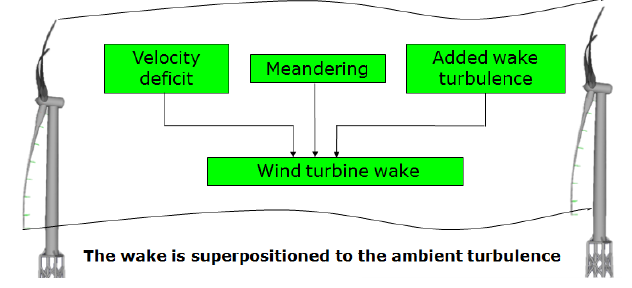
Figure 3. Illustration of the Dynamic Wake Meandering (DWM) method. The upfront wakes are superpositioned to the ambient turbulence, including a stochastic meandering process